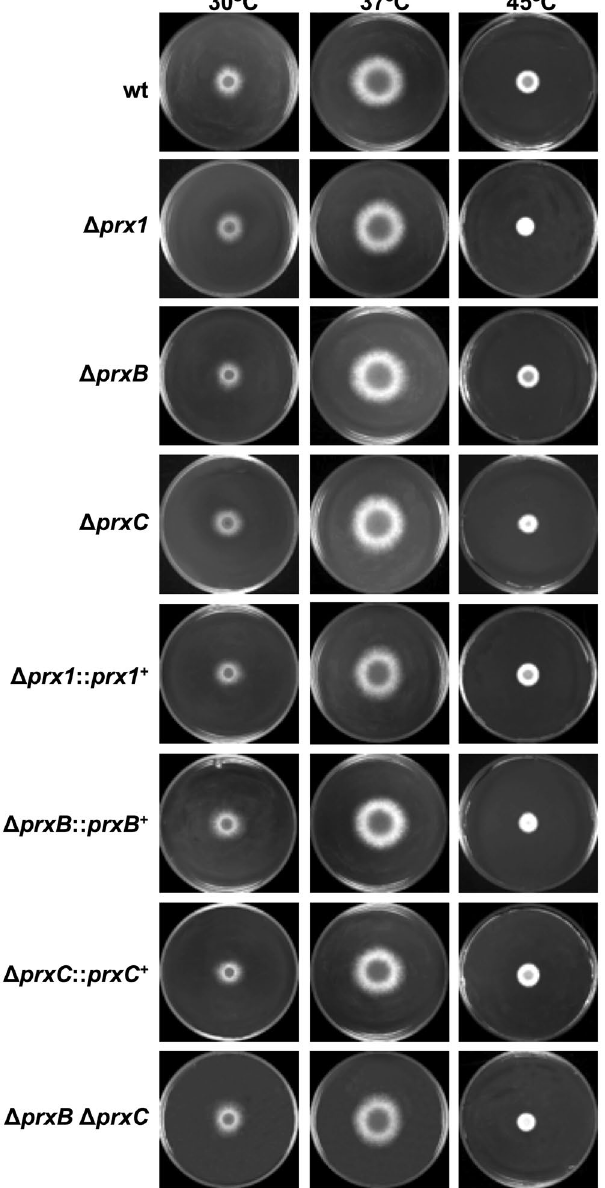
Figure 3. Radial growth of the wild-type and Prx null mutants on MM. 1 × 10 4 conidia of each strain were inoculated onto the center of solid MM and incubated at the indicated temperatures for 72 h. Results are representative of triplicate experiments with similar